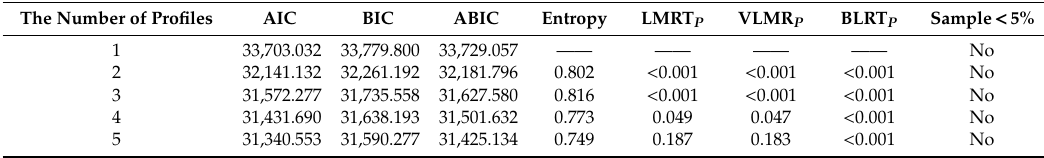
Table 1. Parameters of fit for 1–5 profile solutions for anxiety of junior high school students in the rural areas of Jiangxi Province.